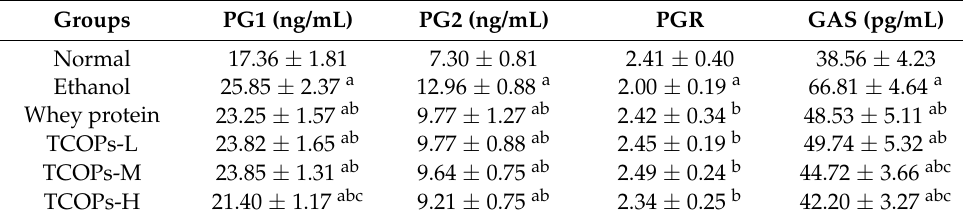
Table 8. Effects of TCOPs on the indicators related to mucosal barrier function in rats.